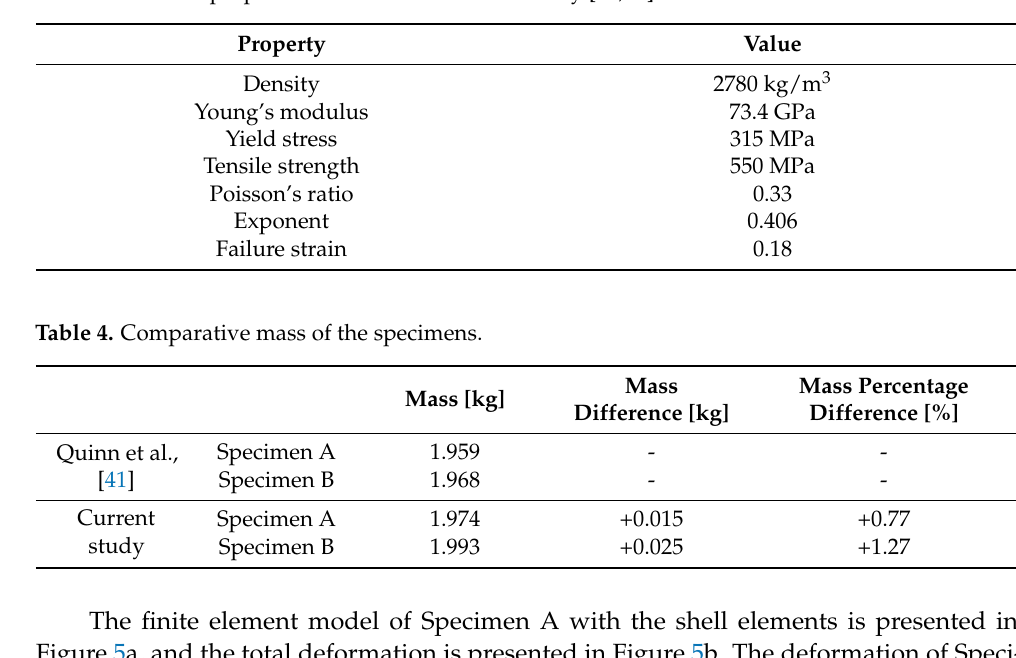
Table 3. Material properties of 2024-T3 aluminum alloy [43,44].